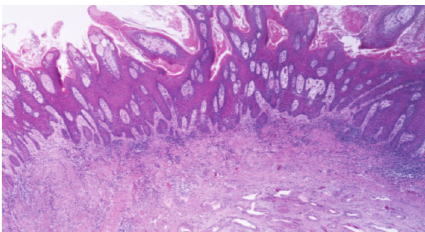
Figure 3: Verrucous carcinoma without invasion of the underlying corpus